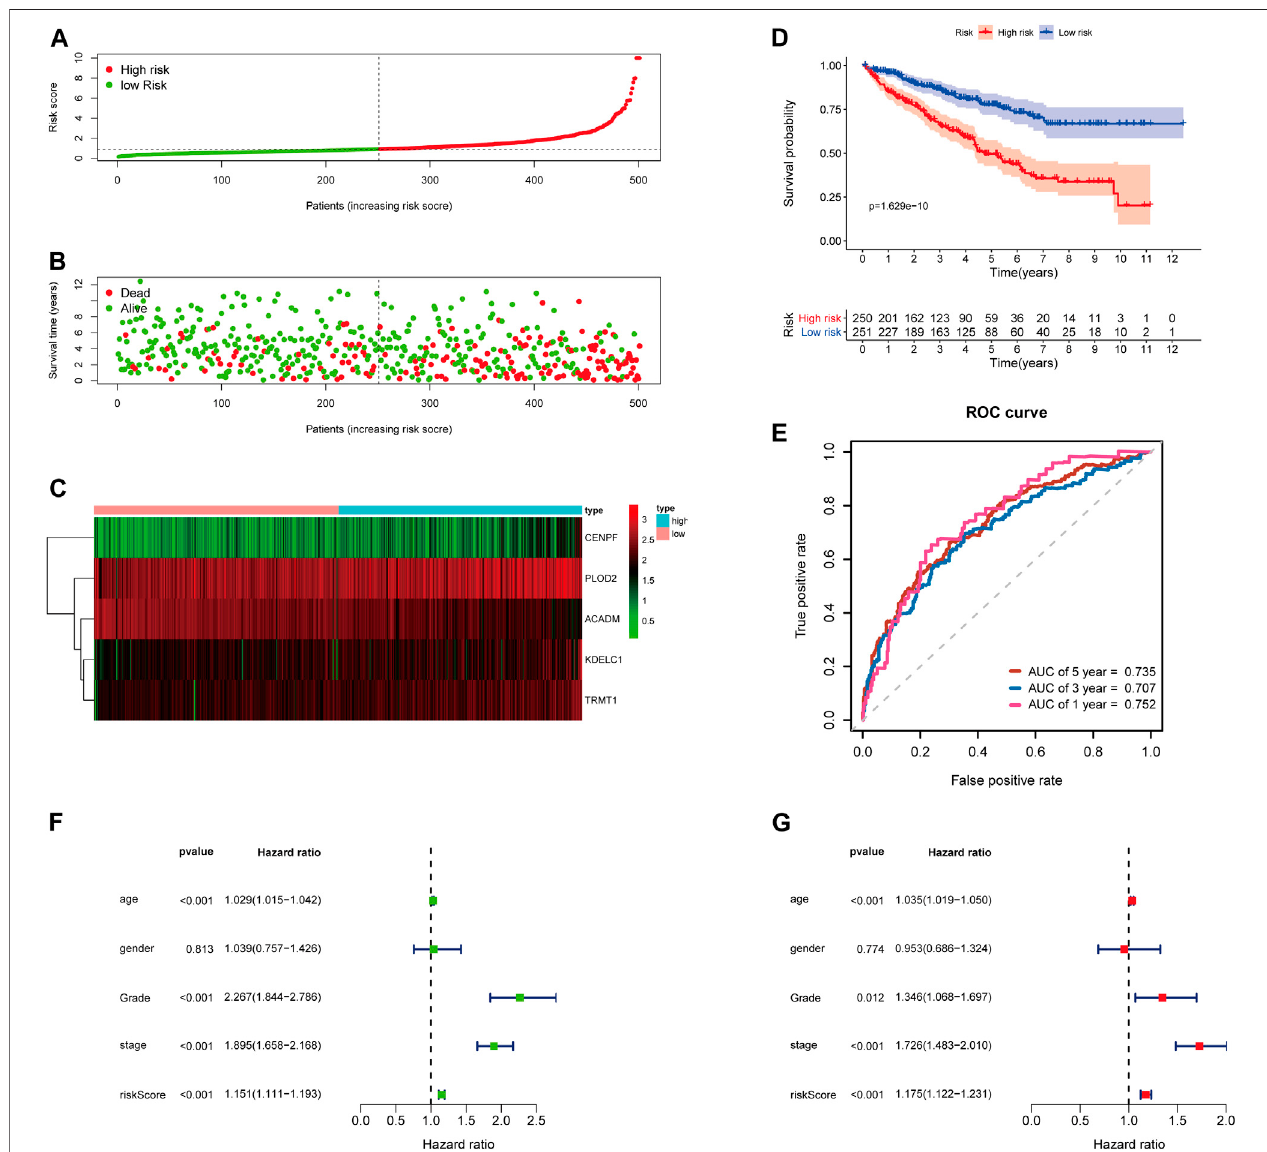
FIGURE 5 | Risk score analysis of the 5-gene signature based on SARS-CoV-2 – related genes in the entire TCGA-KIRC cohort. (A – C) Distribution of risk scores, OS status, and gene expression of model genes; (D) Kaplan – Meier curves of the high- and low-risk subgroup patients; (E) Time-dependent ROC curves for predicting 1-, 3-, and 5-year OS; (F) Univariate and (G) multivariate Cox regression analyses in the entire TCGA-KIRC